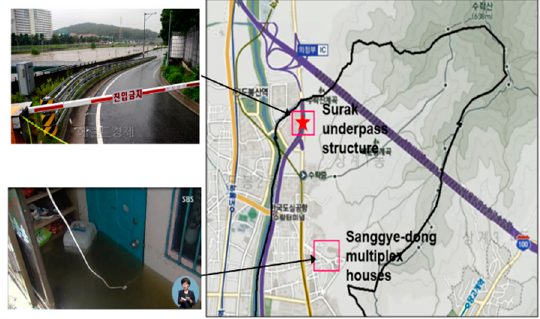
Figure 13. Actual flooding locations in the Bakwoon basin.